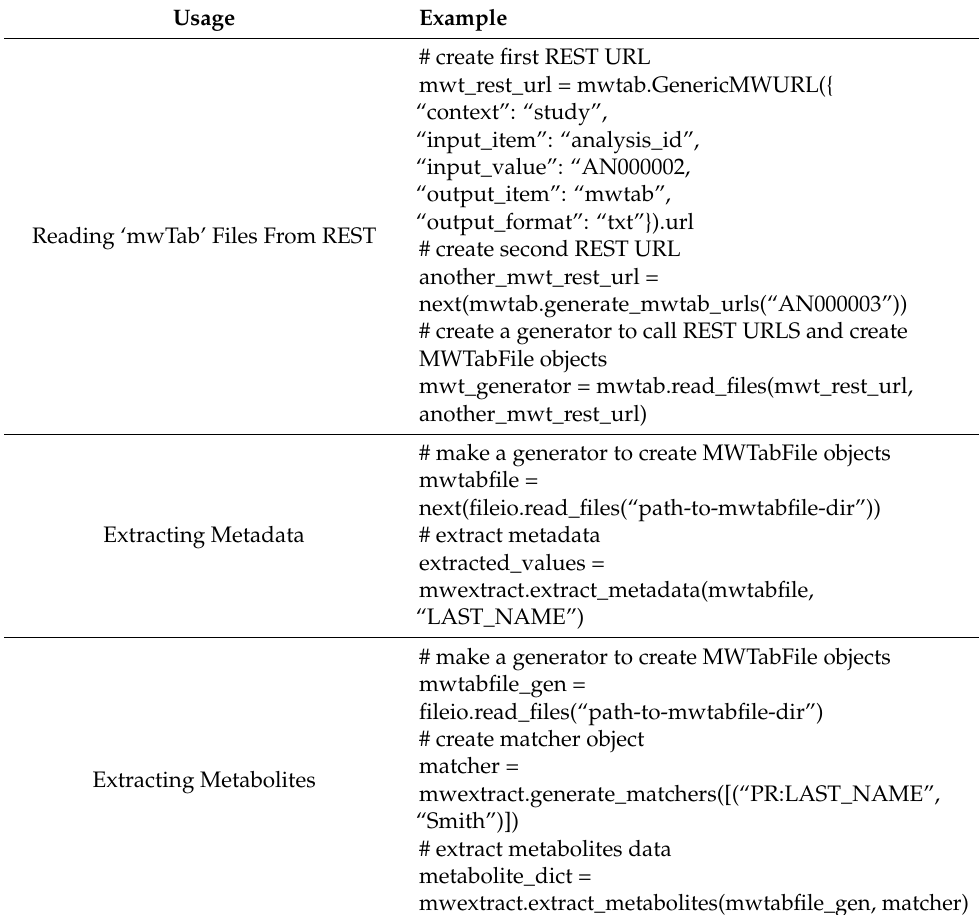
Table 1. Common patterns for using the ‘mwtab’ as a